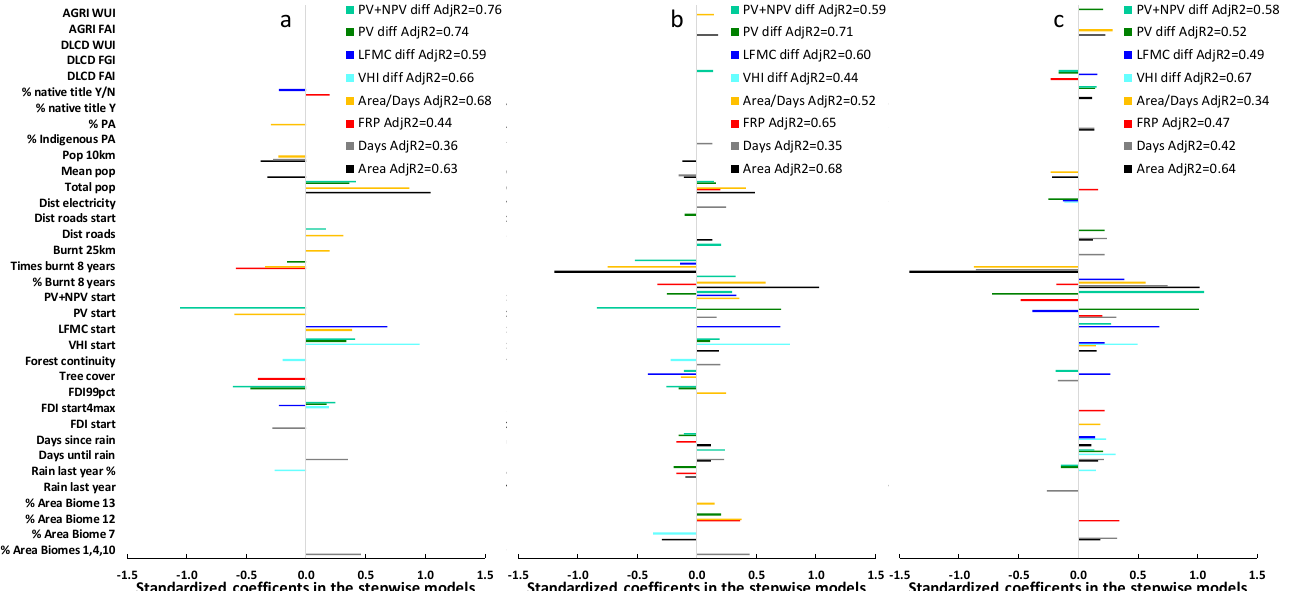
Figure 11. The standardised coefficients of the explanatory variables that were found to be statistically significant in the stepwise regression models for all response variables for ( a ) the Black Summer forest fires in SE Australia ( n = 63); ( b ) the Black Summer forest fires ( n = 205); ( c ) the Black Summer non-forest fires ( n = 186). The models shown in this figure were calculated based on the transformed variables. The adjusted R 2 values of each of the stepwise models are shown in the legend. The colour of the bars indicates the response variable. Only statistically significant coefficients are shown.